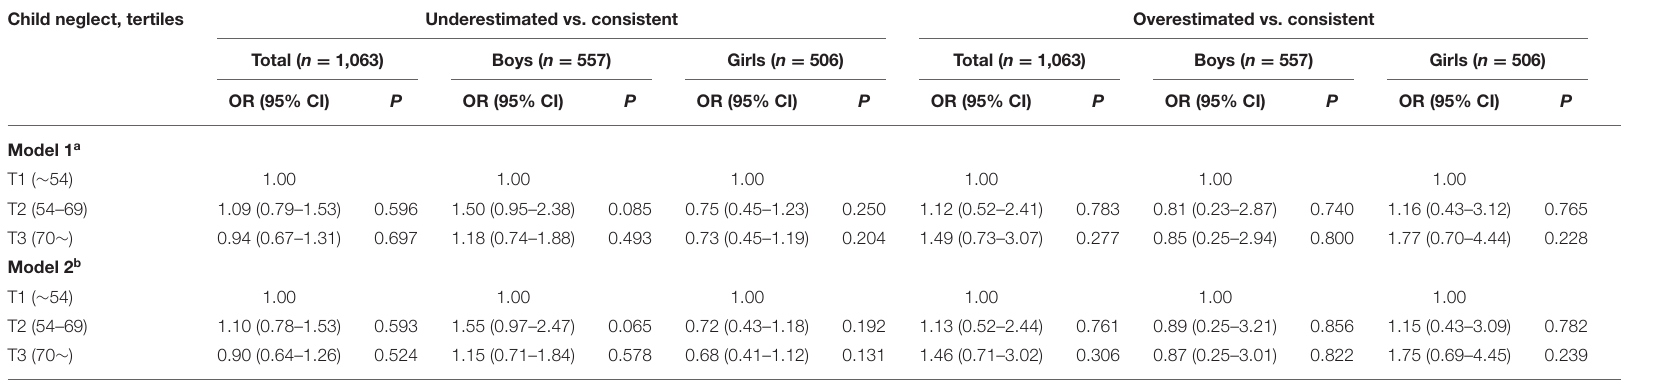
TABLE 3 | Longitudinal analysis for the association of child neglect with the accuracy of body weight perception at follow-up. Child neglect, tertiles Underestimated vs. consistent Overestimated vs.